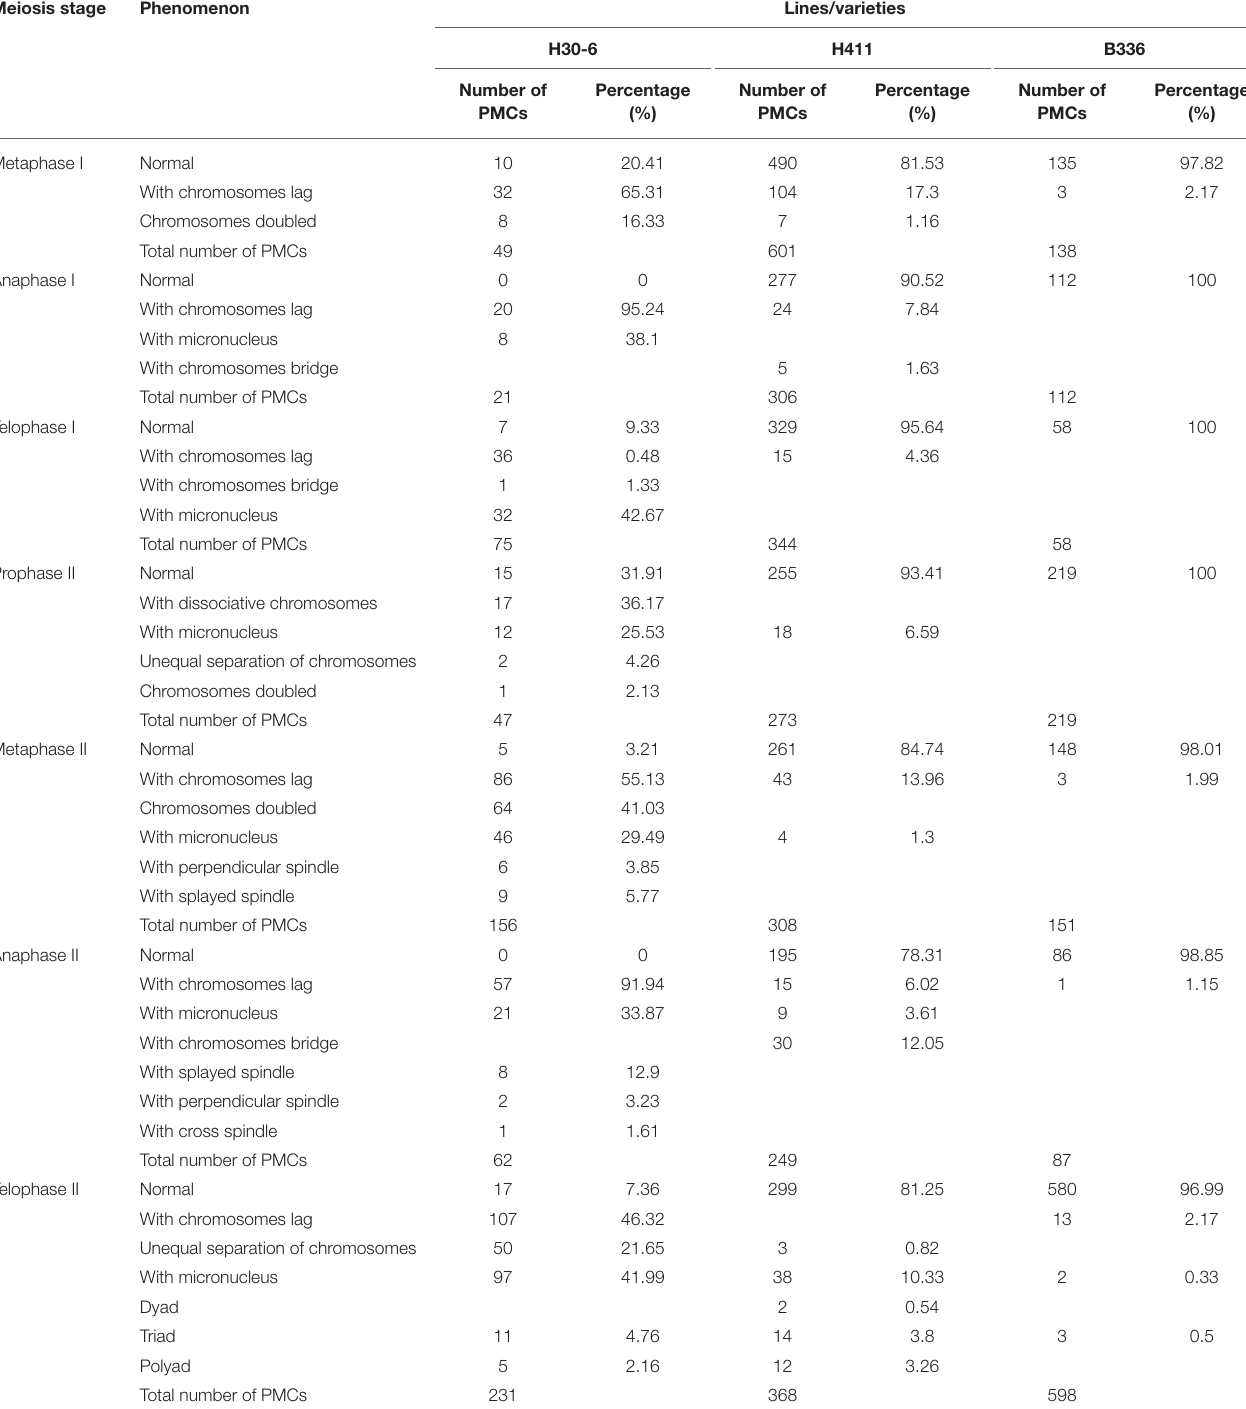
TABLE 3 | Counting of pollen mother cell (PMC) meiosis phenomena. Meiosis